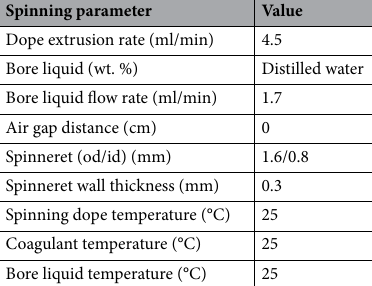
Table 2. Hollow fiber spinning